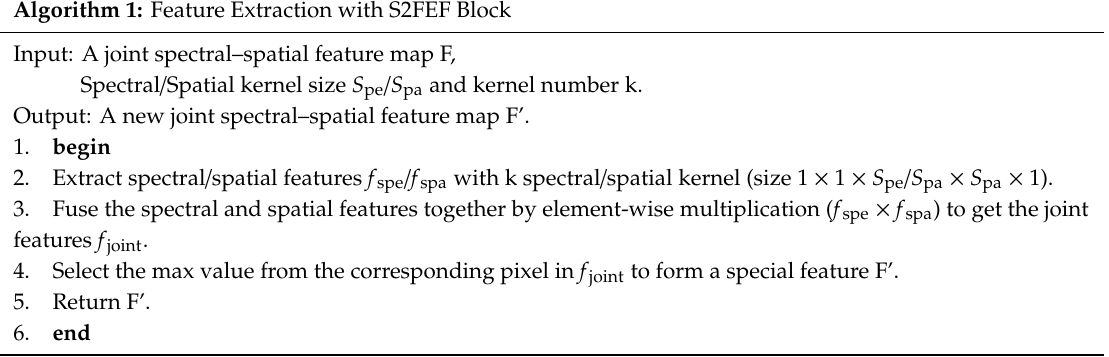
Algorithm 1: Feature Extraction with S2FEF Block